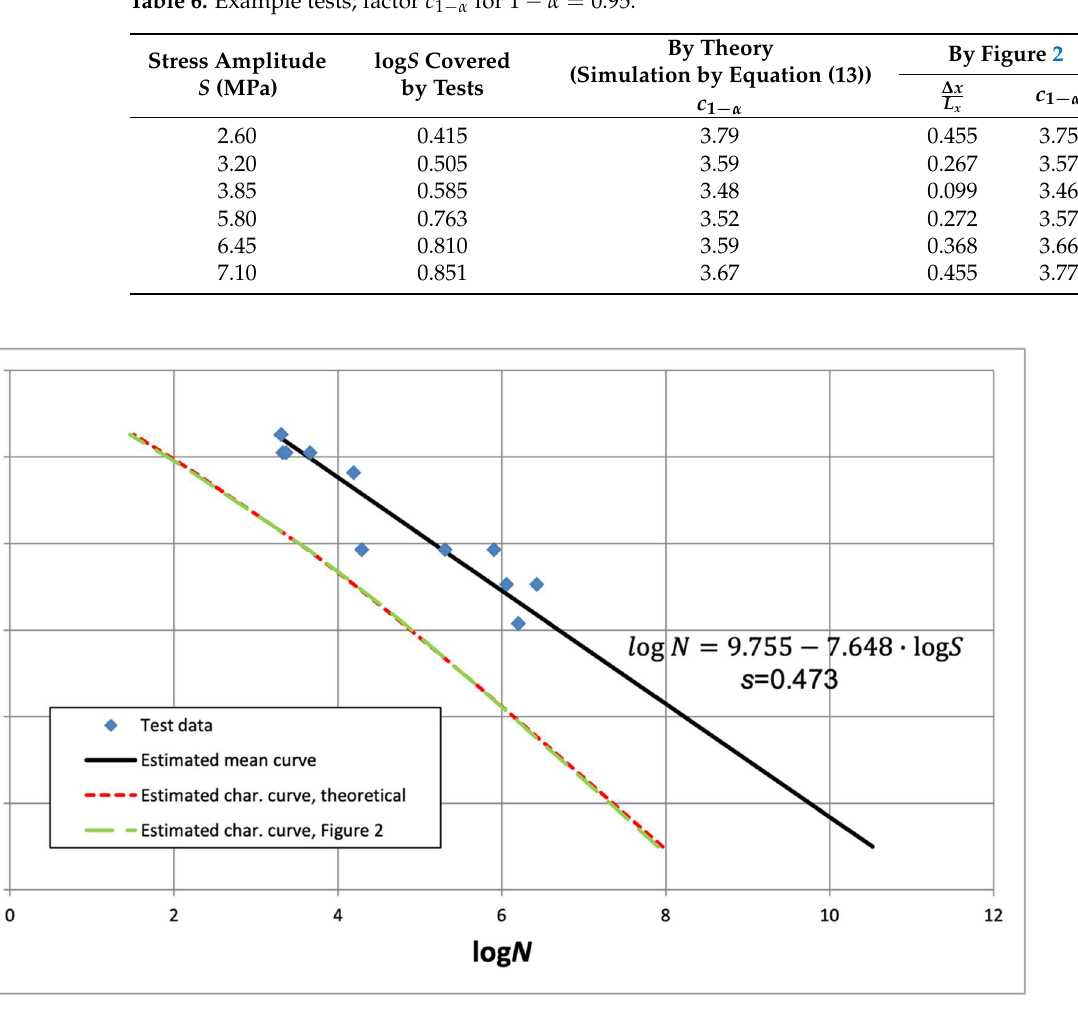
Figure 4. Estimated mean S–N curve on log-log scale and estimated characteristic S–N curve (1) by theoretically correct approach and (2) by Figure 2. Table 6. Example tests; factor 𝑐 (cid:2869)(cid:2879)(cid:3080) for 1 − 𝛼 = 0.95 . Stress Amplitude